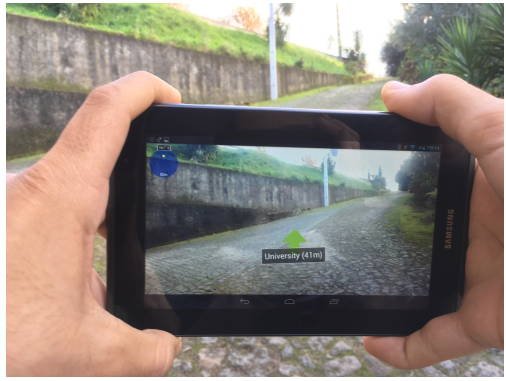
Figure 3. Orientation system using augmented